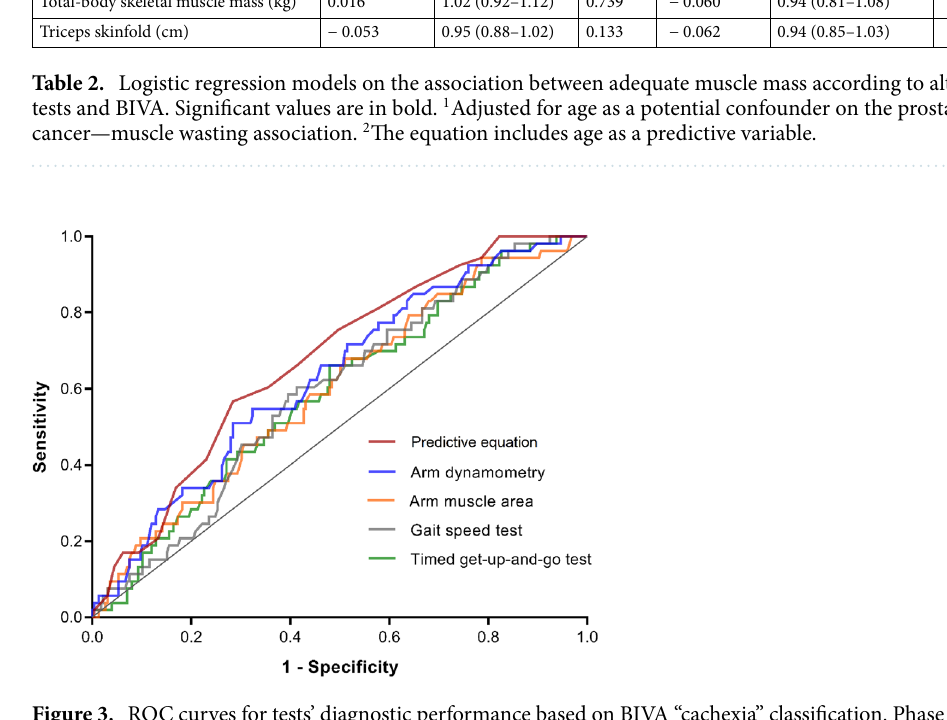
Figure 3. ROC curves for tests’ diagnostic performance based on BIVA “cachexia” classification. Phase angle predictive model (°): AUC = 0.68 (0.60–0.75; p < 0.0001). Arm dynamometry (kg): AUC = 0.63 (0.55–0.71; p = 0.003). Arm muscle area (cm 2 ): AUC = 0.60 (0.52–0.68; p = 0.025). Gait speed test (m/s): AUC = 0.59 (0.52– 0.67; p = 0.033). Timed Get-Up and Go test (s): AUC = 0.59 (0.51–0.67; p =